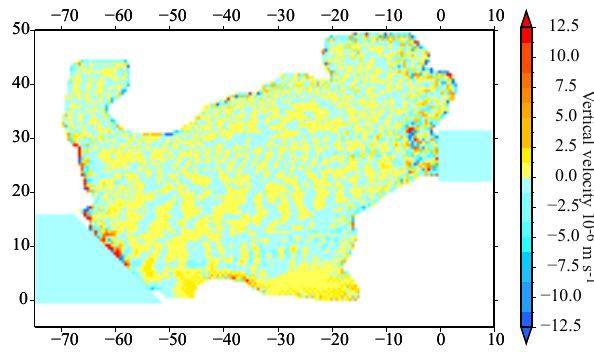
Fig. 7. Upwelling without wind. Vertical velocity at 40m depth for the NOWIND